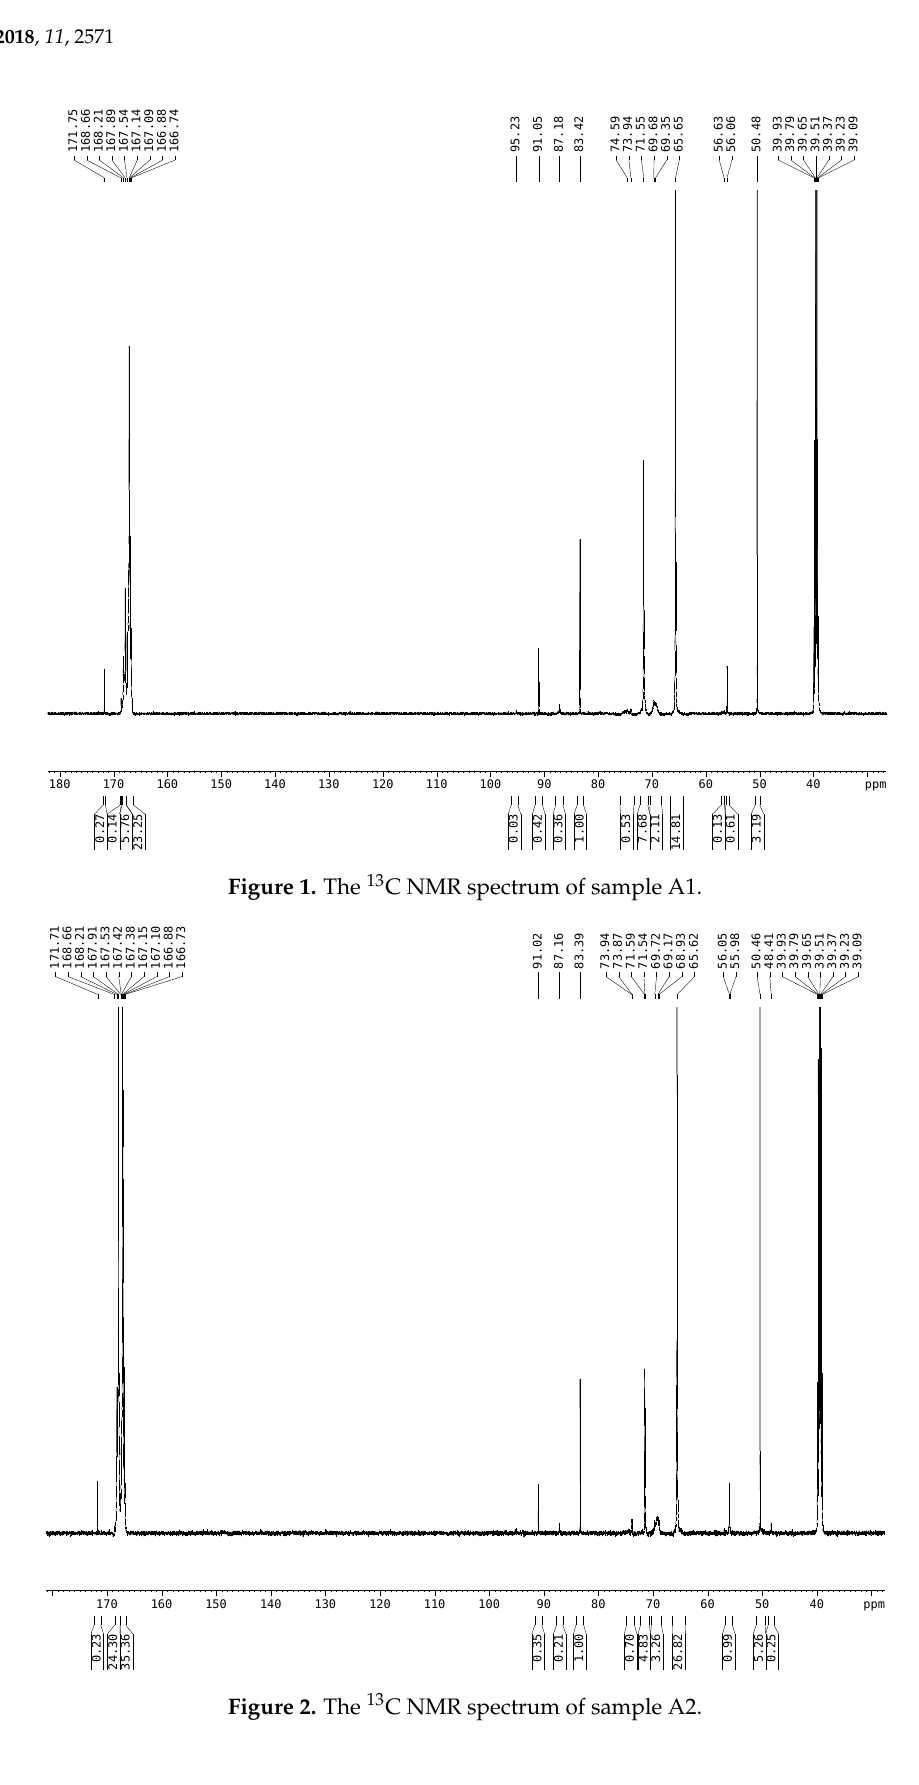
Figure 2. The 13 C NMR spectrum of sample